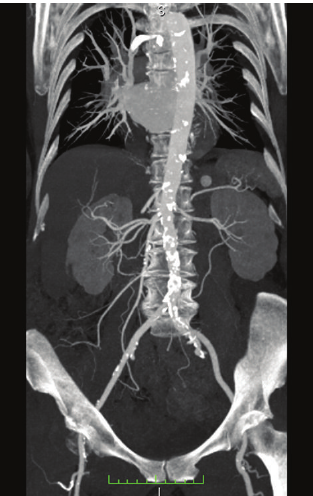
Figure 6: Aortoiliac CT Angiography for planning of transcatheter aortic valve implantation (TAVI), using high-pitch 128-dual source CT . Severe calcifications of the abdominal aorta but the right iliac artery are spared from atherosclerosis and do not show tortousity. Transfemoral access was possible via the right iliac